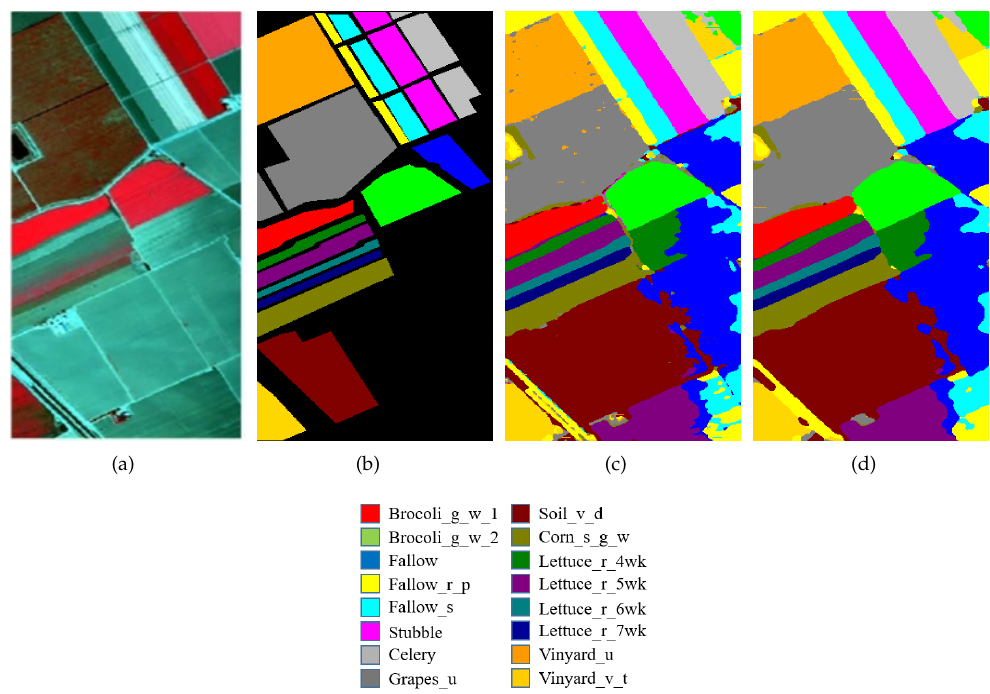
Figure 7. Visual classification results on the SA. ( a ) A three-band color composite image, ( b ) the